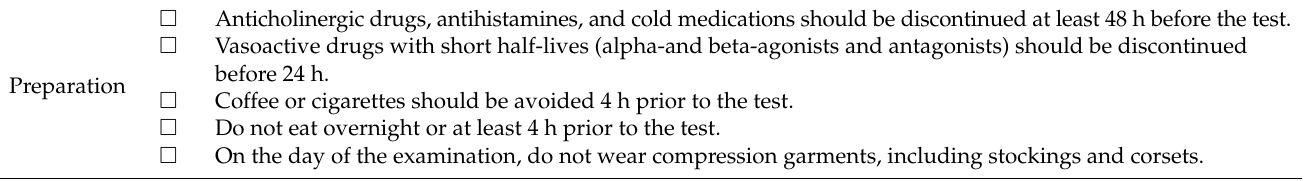
Table A1. Summary of the performed autonomic function screening test